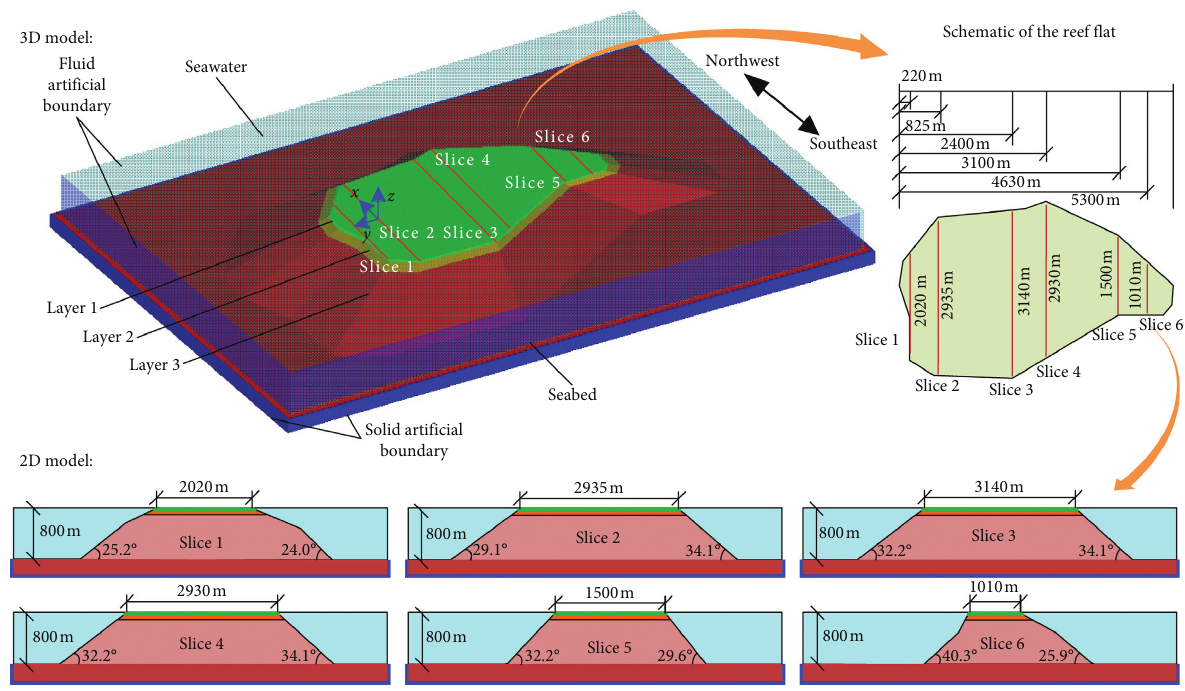
Figure 2: 3D and 2D calculation models of the reef-seawater system. Table 1: Topographic and material parameters of the Zhubi Reef model.